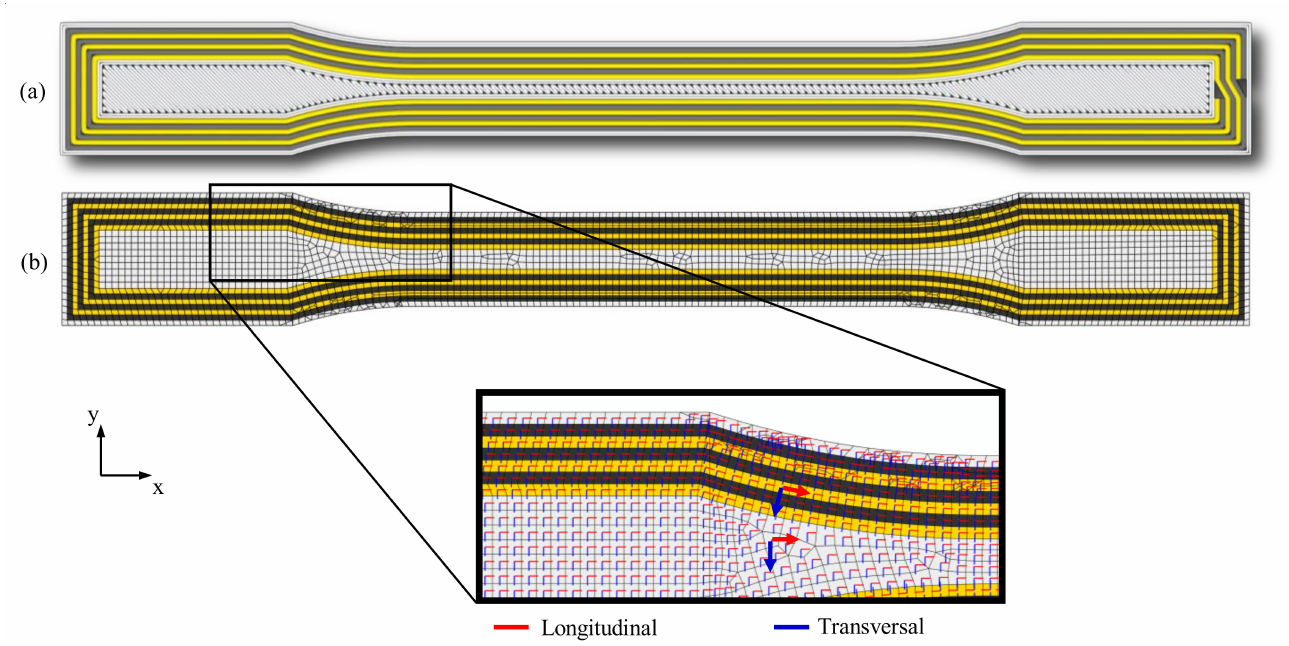
Figure 6. Comparison between the following: ( a ) generated tool paths in the slicing software and ( b ) a modeled fiber-reinforced layer with the longitudinal and transverse orientation of the materials with red and blue arrows,